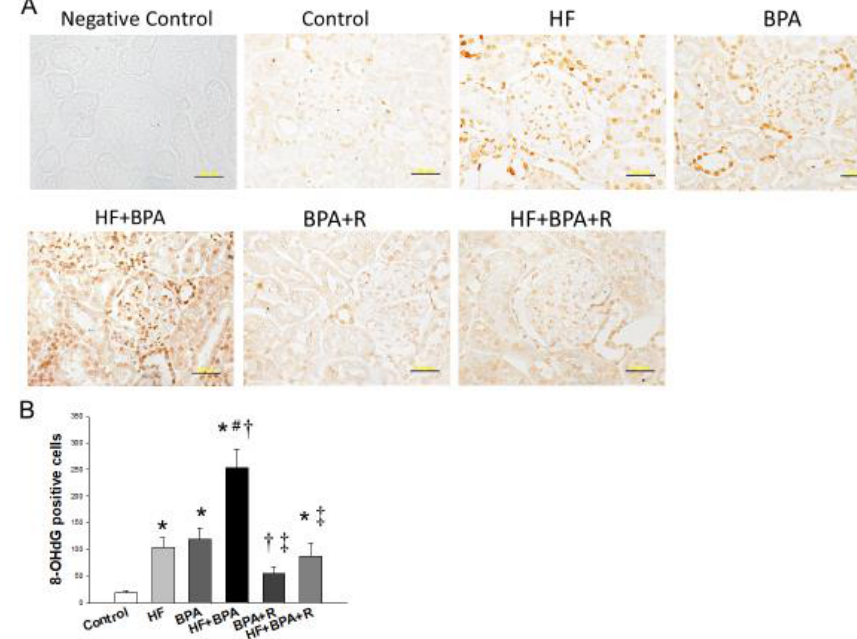
Figure 4. ( A ) Light micrographs illustrating immunostaining for 8-hydroxydeoxyguanosine (8-OHdG) in the kidney in male o ff spring at 16 weeks of age. Bar = 50 µ m. ( B ) Quantitative analysis of 8-OHdG-positive cells per microscopic field ( × 400). n = 5 / group; * p < 0.05 versus control; # p < 0.05 versus HF; † p < 0.05 versus BPA; ‡ p < 0.05 versus HF +